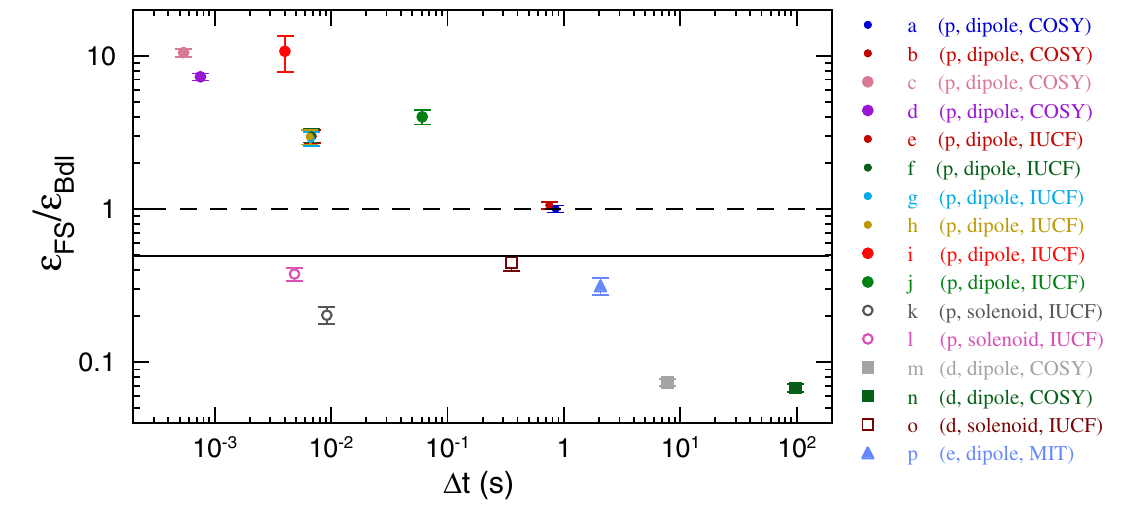
FIG. 3. (Color) Ratio of E to E is plotted vs the ramp time (cid:1) t giving P (cid:1) 0 in each (cid:1) t curve [31]; for example, points (d) and (m) FS Bdl is the resonance strength obtained by fitting data in each (cid:1) t curve to Eq. (3), the modified come from Figs. 1 and 2, respectively. E FS is obtained using each data point’s R Bdl in Eq. (4) or (5). The dashed and solid lines show the ratios Froissart-Stora equation; E Bdl predicted by [26–28] and [29,30], respectively. Note that points (a) and (b) overlap, as do points (e)–(h). The data for all points are listed in Table